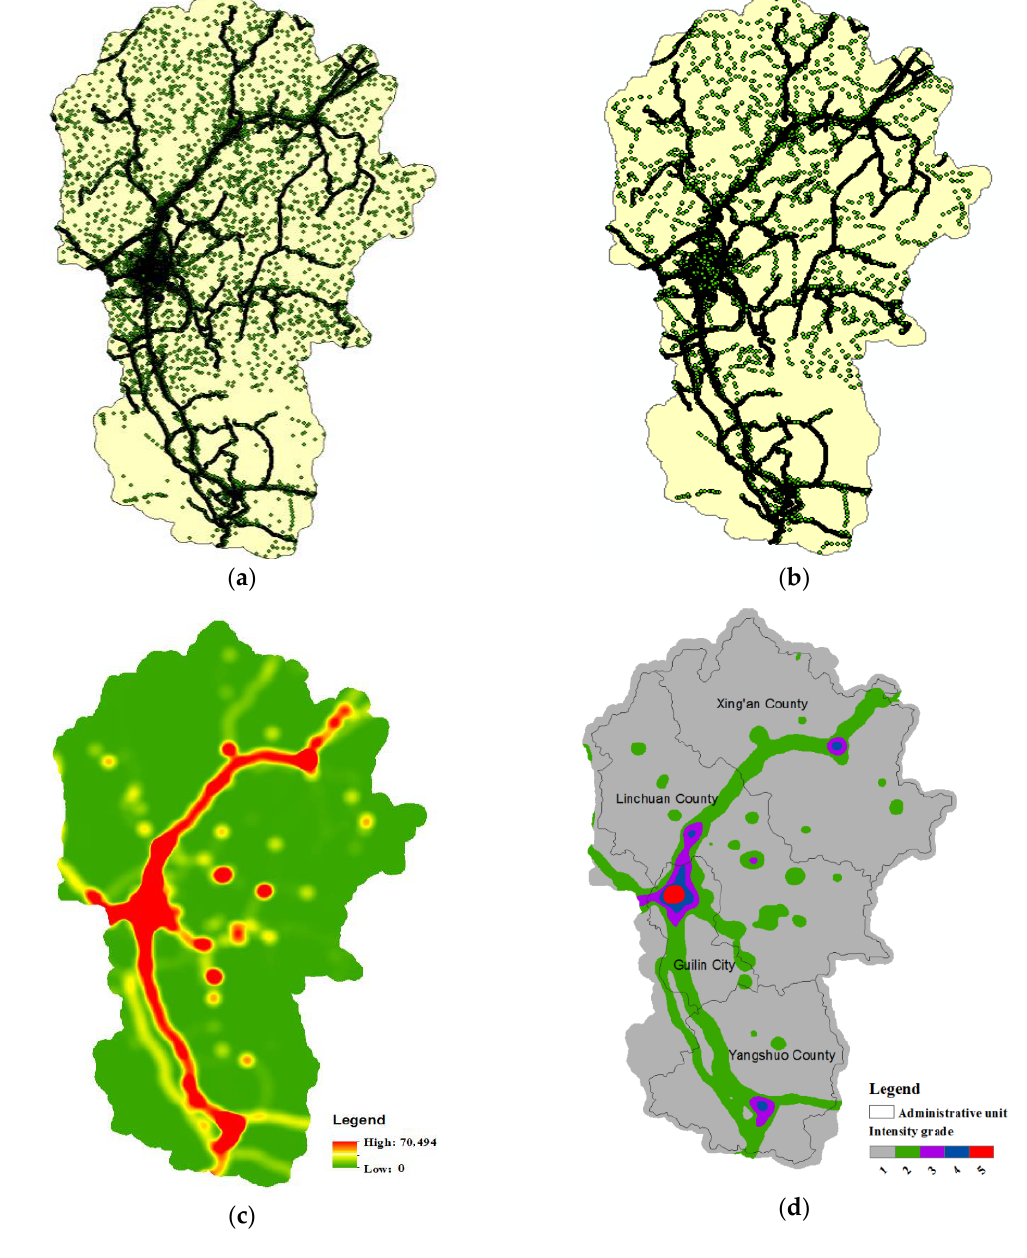
Figure 3. Human activity analysis in Lijiang River Basin. ( a ) Raw GPS trajectories; ( b ) GPS trajectories after preprocessing; ( c ) intensity distribution; ( d ) intensity grade. Table 1. Part of the GPS tracking data in Lijiang River Basin.